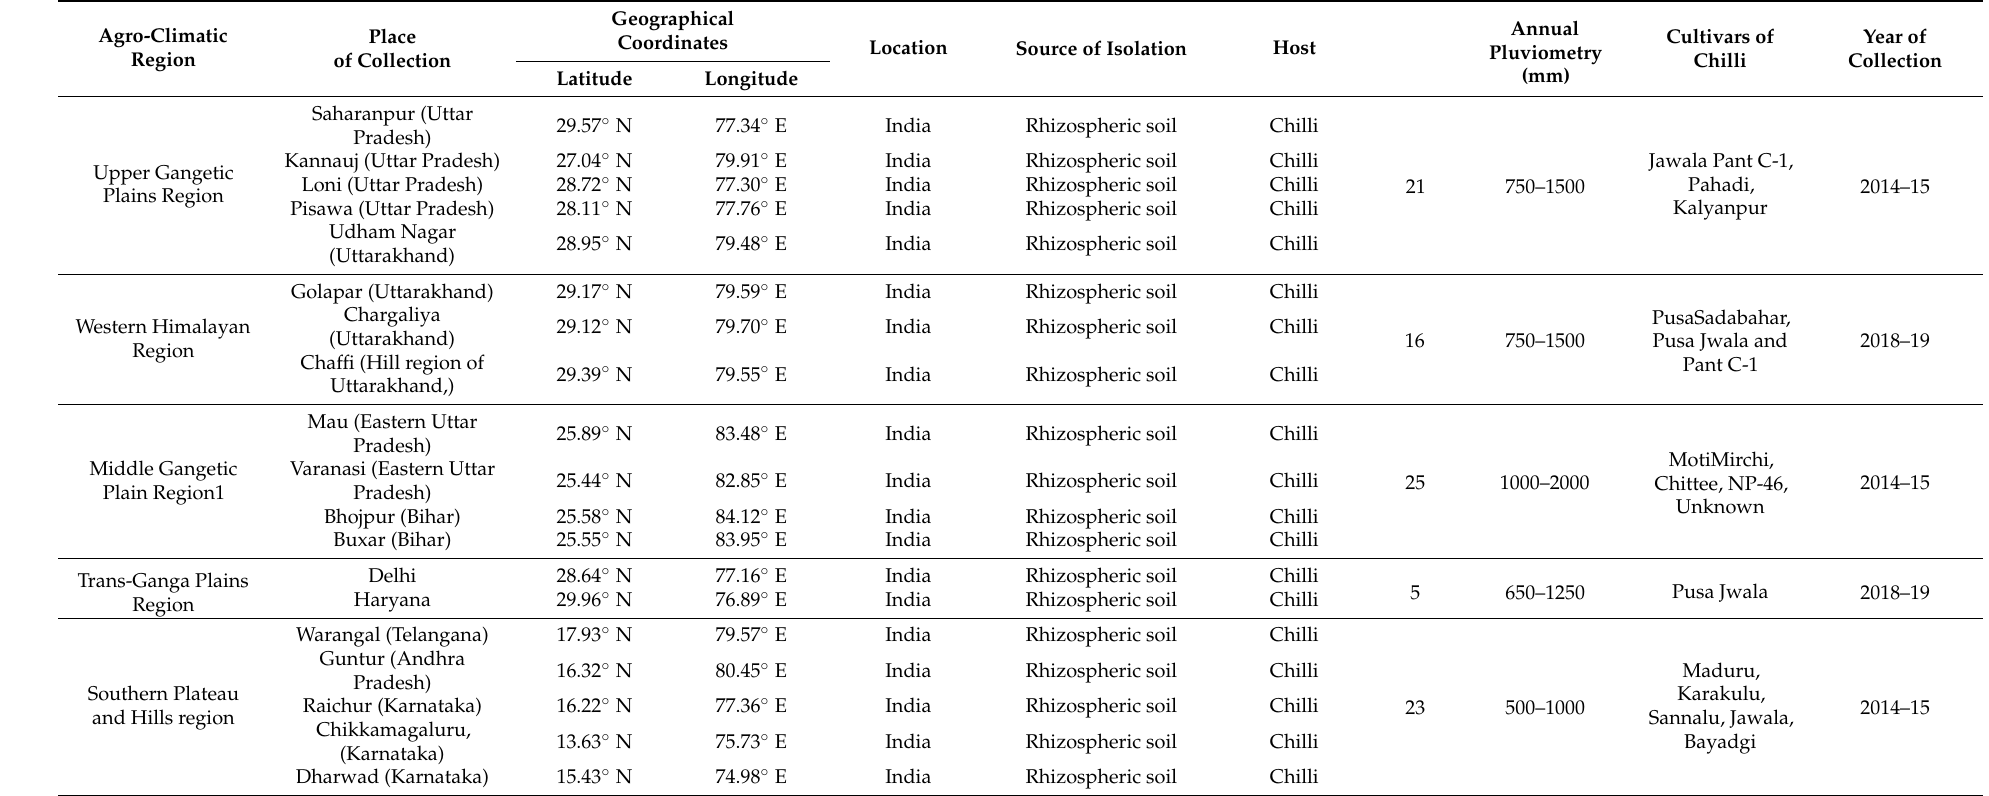
Table 1. The location of chilli rhizospheric soils collected from the sampling sites of different agro-climatic regions of India. Agro-Climatic